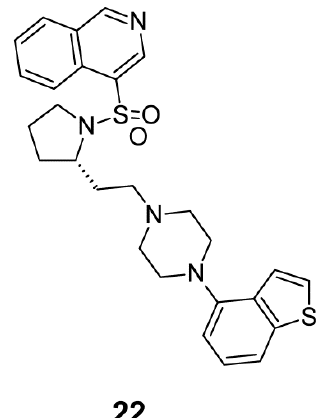
Figure 12. Multi-target ligand of aminergic G protein-coupled receptors (GPCRs) with SERT inhibitory properties.